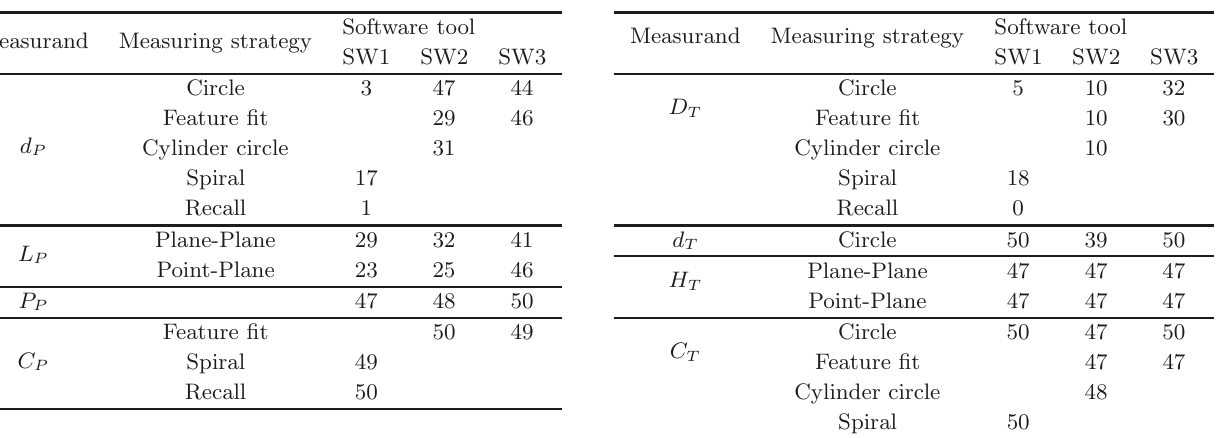
Table 5. Bias contribution to the measurement uncertainty ( | b | / U CT in %) calculated for the